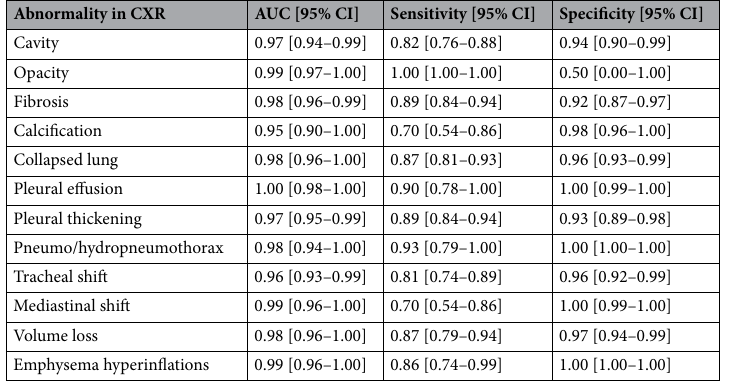
Table 3. Estimates of diagnostic metrics of lung wise abnormalities in EfficientNetB4 model. 95% CI for AUC calculated using Hanley & McNeil method. 95% CI for sensitivity and specificity calculated using Wilson Score method. AUC area under the receiver operating characteristic, CI confidence interval.